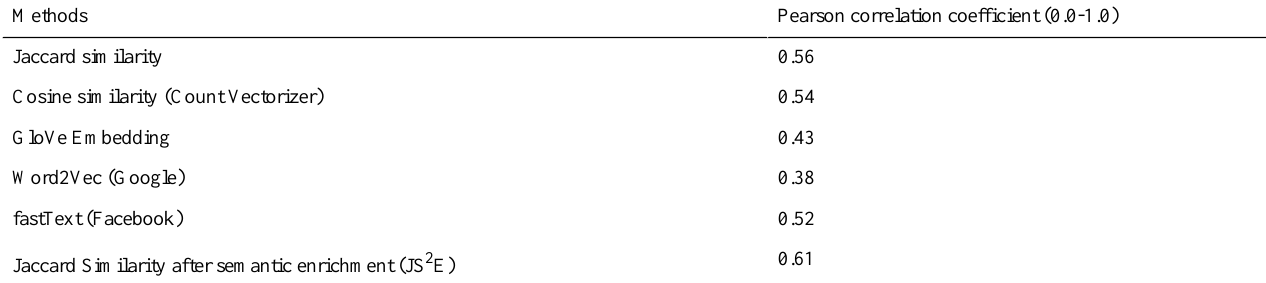
Table 9. Comparison of similarity